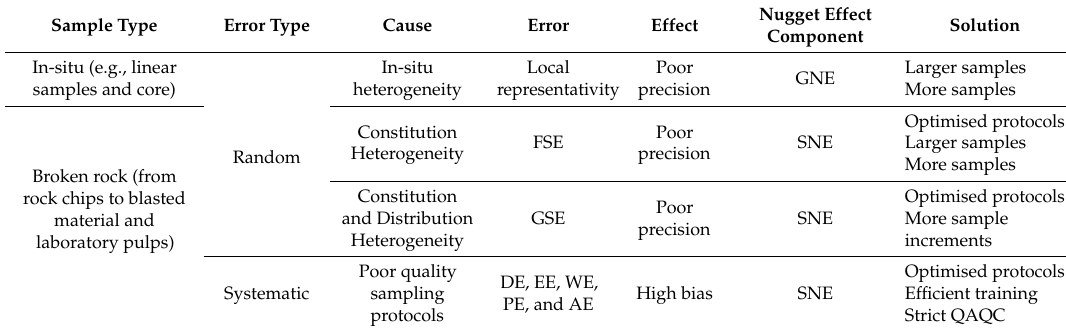
Table 3. Cause, effect, and solutions to TOS